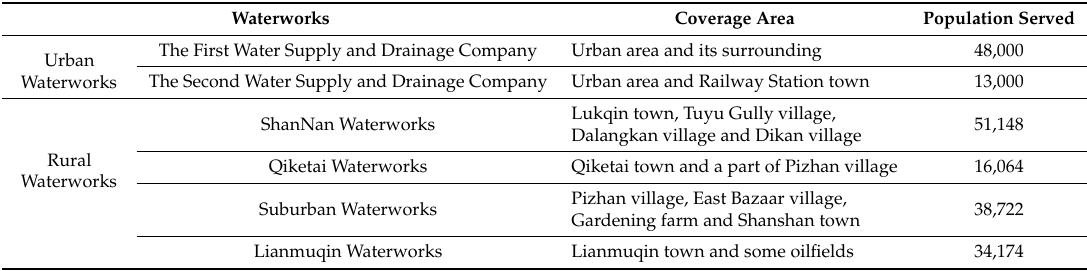
Table 1. Centralized water supply projects in Shanshan County.